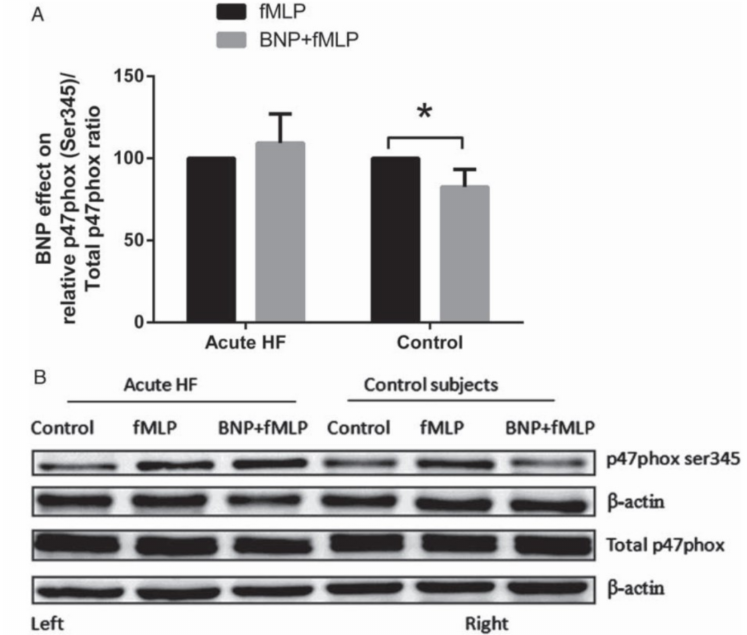
Figure 4. Effect of BNP on phosphorylation of p47phox Ser345. ( A ) In acute heart failure patients ( n = 9) there is attenuation of BNP-induced suppression of p47phox Ser345 phosphorylation stimulated by N -formyl-methionyl-leucyl-phenylalanine (fMLP), which is seen in neutrophils from healthy subjects ( n = 7). The relative ratio of p47phox Ser345 to total p47phox for samples treated with fMLP was taken as control (100%). * p < 0.05. ( B ) Representative immunoblots of acute heart failure patients and control subjects. Note suppression of phosphorylation of Ser345 by BNP in control subjects but not acute heart failure patients